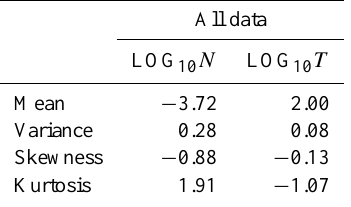
Table 1. The mean, variance, skewness, and kurtosis of the loga- rithm of density and temperature 151574 data points values for the data plotted in Figs. 2 and 3. The mean Kp index for these data is 1.85 and the mean AE index is